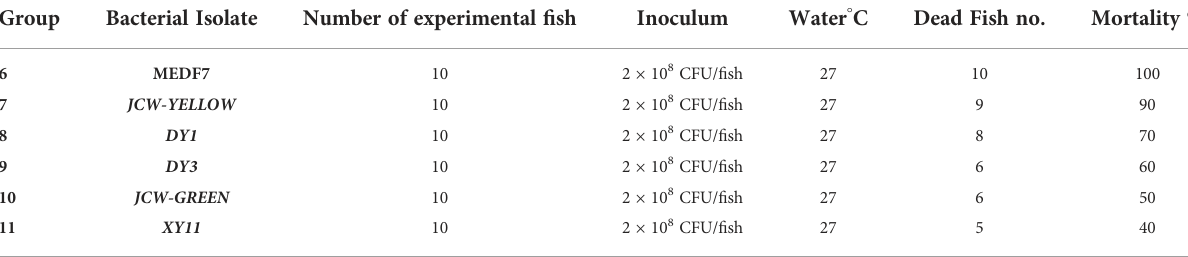
TABLE 5 Experiment of arti fi cial infection of 6 Vibrio